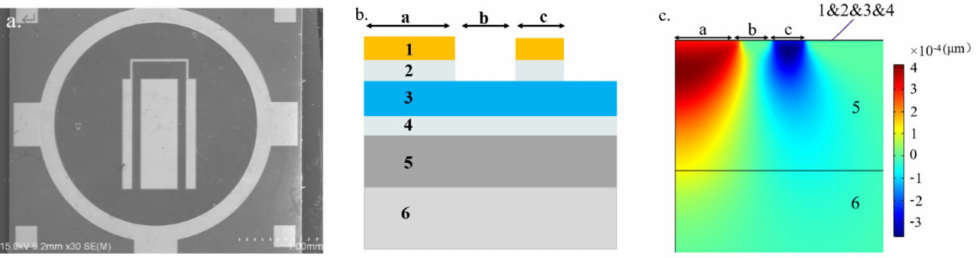
Figure 4. ( a ) SEM image of the device used in the LDV test; ( b ) 2D cross-sectional view of the 2-port electrode design used as input for the FEM simulations; ( c ) FEM results for the local displacement perpendicular to the wafer